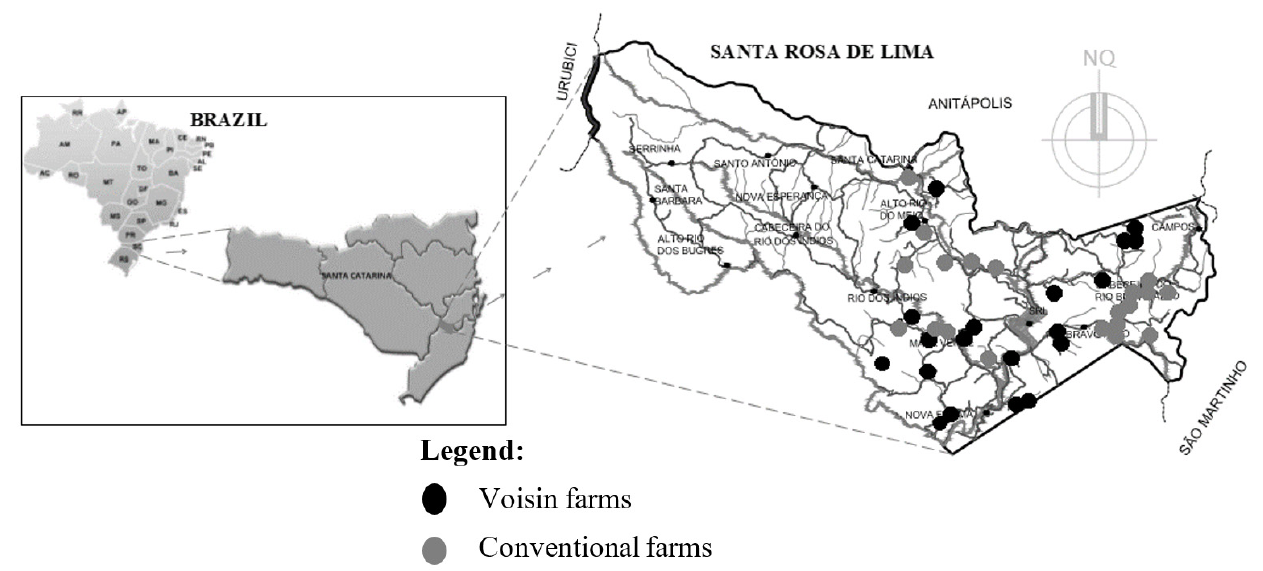
Figure 2. Farmers’ Sample Location. Source: [44].